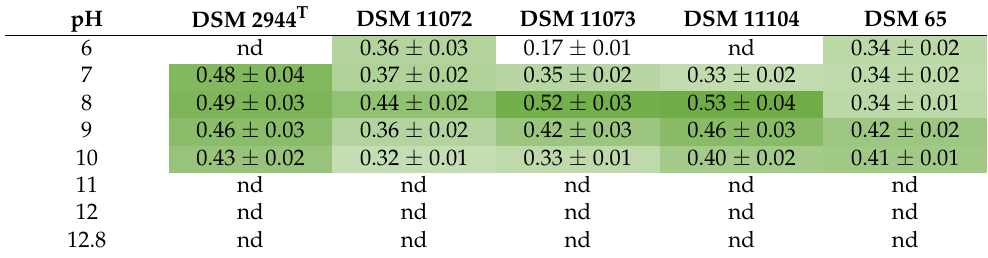
Table 7. Growth rates of different pH values in h − 1 . All cultures were grown in MSM + 20 mM glucose adjusted to the respective pH. Growth rates were determined by a Growth Profiler experiment, and an automatic algorithm was applied to the online data. All values represent n = 3. nd = not detected. pH DSM 2944 T